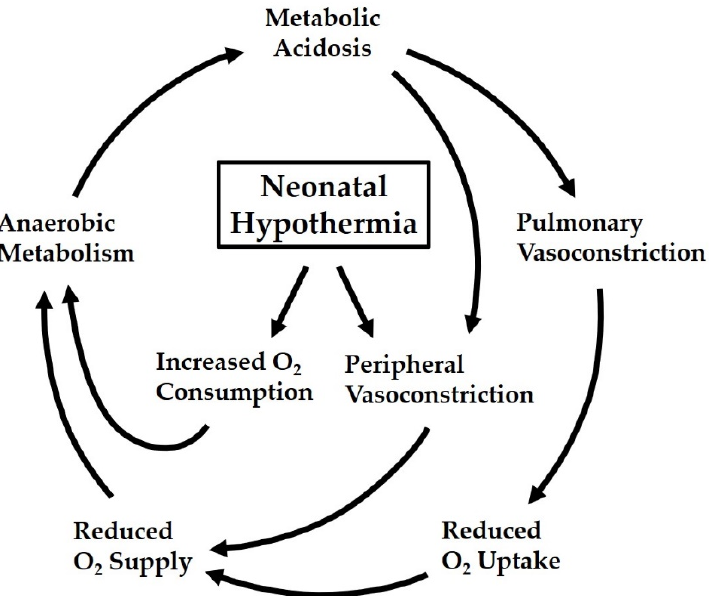
Figure 2. Vicious cycle of hypothermia-triggered hypoxia in neonates. The increase in O 2 consumption rate caused by non-shivering thermogenesis in brown adipose tissue conflicts with the limited O 2 supply by the just aerated lungs, especially under conditions of cold-induced peripheral vasoconstriction. The metabolic (lactate) acidosis resulting from higher anaerobic metabolism leads to an increase in pulmonary vascular resistance, which further impairs O 2 uptake in the lungs and thus aggravates the mismatch between O 2 demand and supply (adapted from [3]).